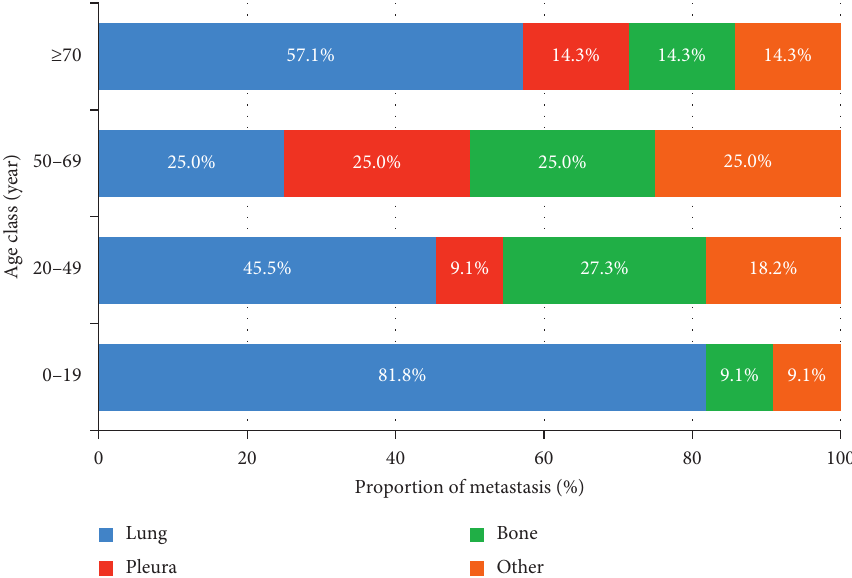
Figure 4: Most important metastasis sites according to age for bone sarcomas diagnosed in 2009–2012 in 15 Italian population-based cancer